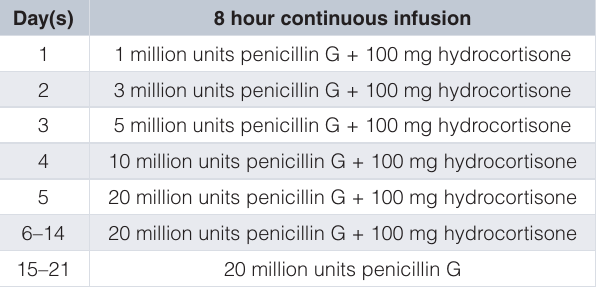
Table 3. 21-day treatment regimen reported to provide long-term reversal of symptoms in syphilitic ALS, when administered every 3 months for four times 4